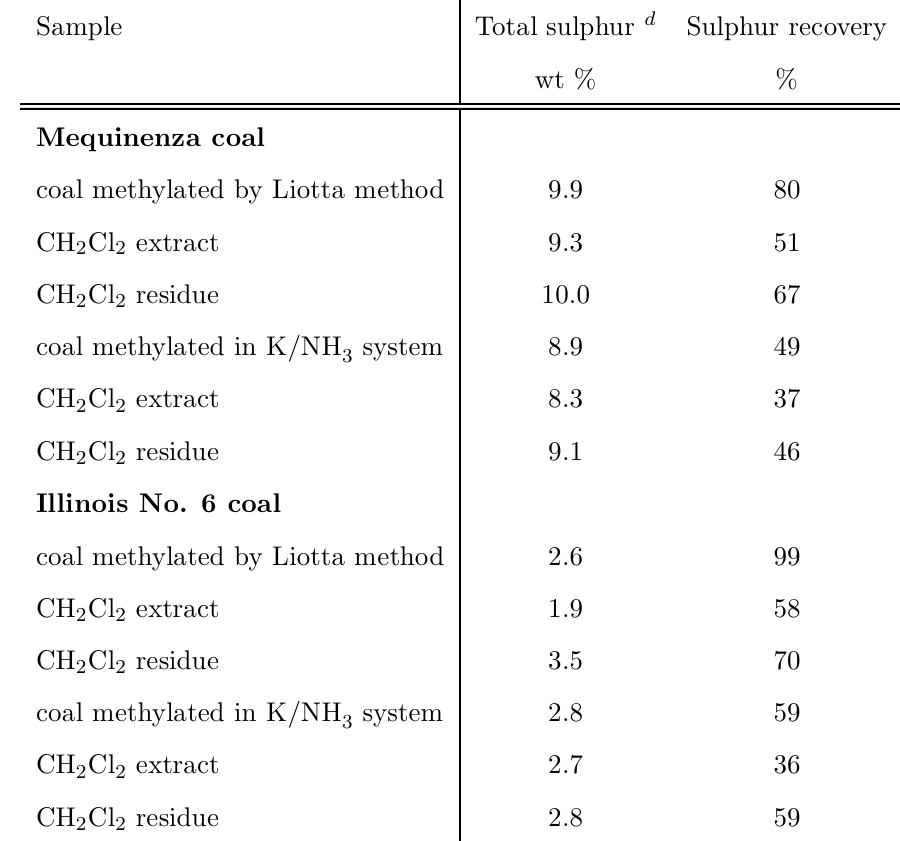
Table 4 Total content of sulphur in methylated coals, their CH 2 Cl 2 extracts and residues and sulphur recovery by AP-TPR